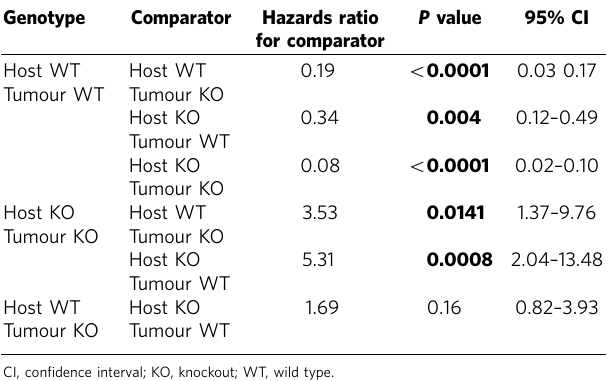
Table 1 | Log-rank (Mantel-Cox) statistical analysis of the two independent repeat studies with PD-L1 WT or KO mice bearing PD-L1 WT or KO MC38